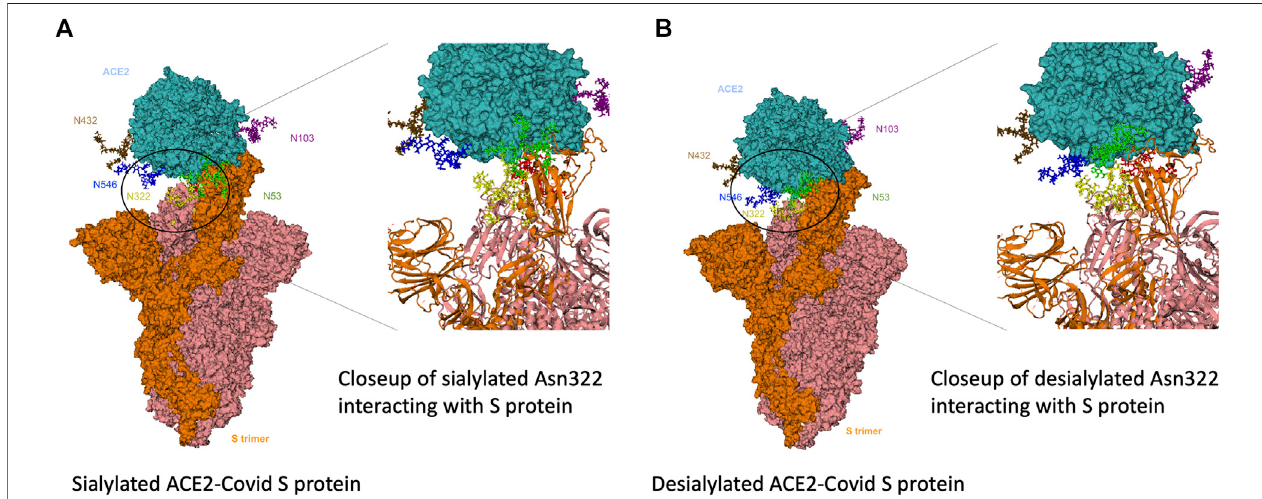
FIGURE8| ModelledsialylatedanddesialylatedACE2-CovidSproteincomplexes.3DstructuralmodelingofglycosylatedACE2interactingwithS-protein.Results from glycomics and glycoproteomics of HEPG2 cell lines were used to generate (A) fully-desialylated and (B) fully-sialylated homologs of ACE2, interacting with S-protein.